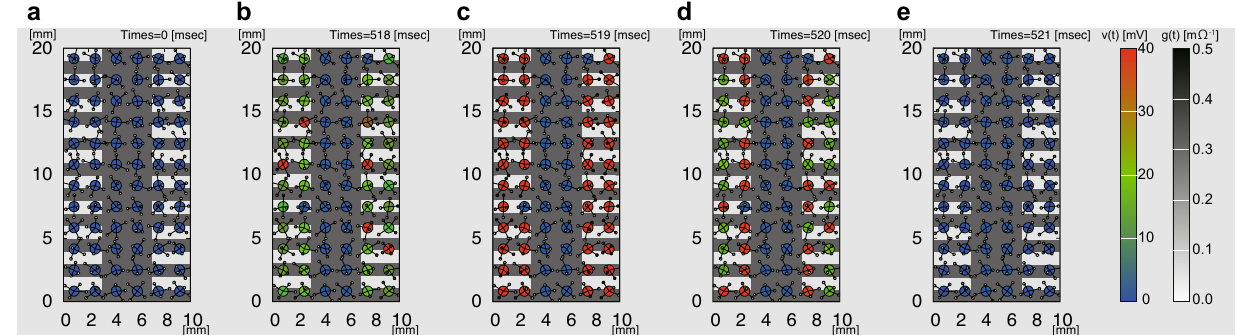
Figure 4. Numerical results of receptive fields at different time points. ( a ) Initial setup. ( b–e ) Four successive time moments [ t = 518 ( b ), 519 ( c ), 520 ( d ), and 521 ms ( e )], where typical responses of mechanoreceptors to mechanical input signals are shown. Large circles represent receptive fields, whose action potential activities v ( t ) are indicated by the color bar; red and blue represent the excited and the resting state, respectively. Each receptive field has a neuron that integrates signals from mechanoreceptors, which are represented by small circles. The activities of the mechanoreceptors and the conductance g ( t ) are represented by the grayscale color. Connections between a receptive field and mechanoreceptors are indicated by lines. After calculating the responses of multiple receptive fields, both the firing rate of each receptive field and the firing timing synchronicity (the Shannon entropy) over multiple receptive fields are calculated. Supplementary Videos 1–3 demonstrate the time-lapse results of how 72 receptive fields responded to the fishbone pattern of 1.0 mm and 0.4 mm intervals under PM1 and PM2